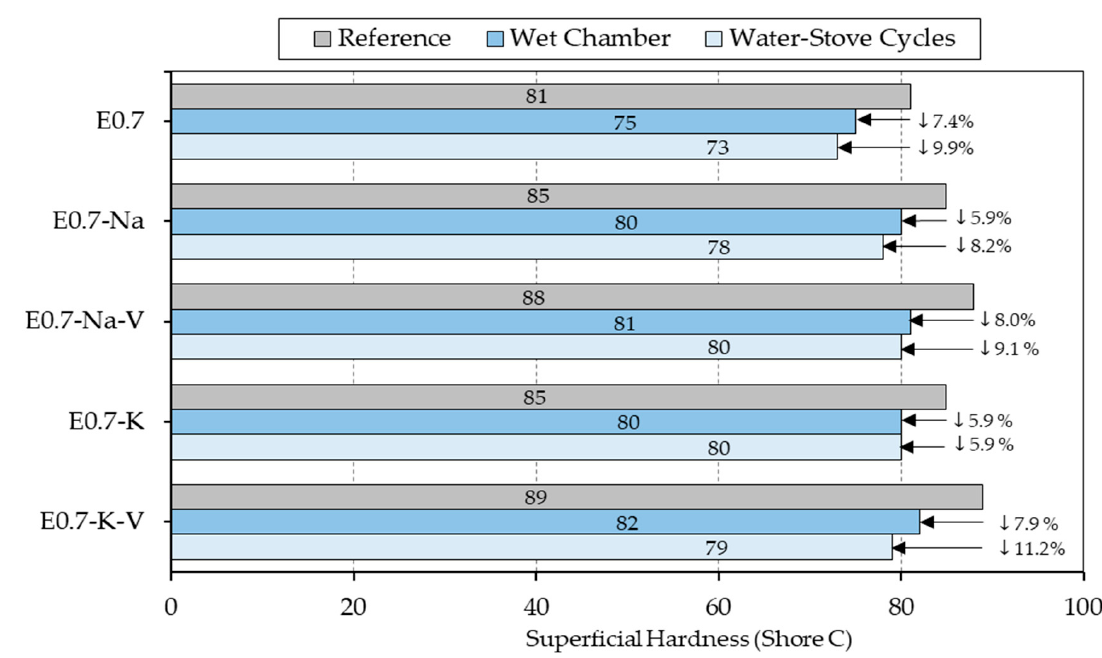
Figure 5. Shore C hardness test results compared.